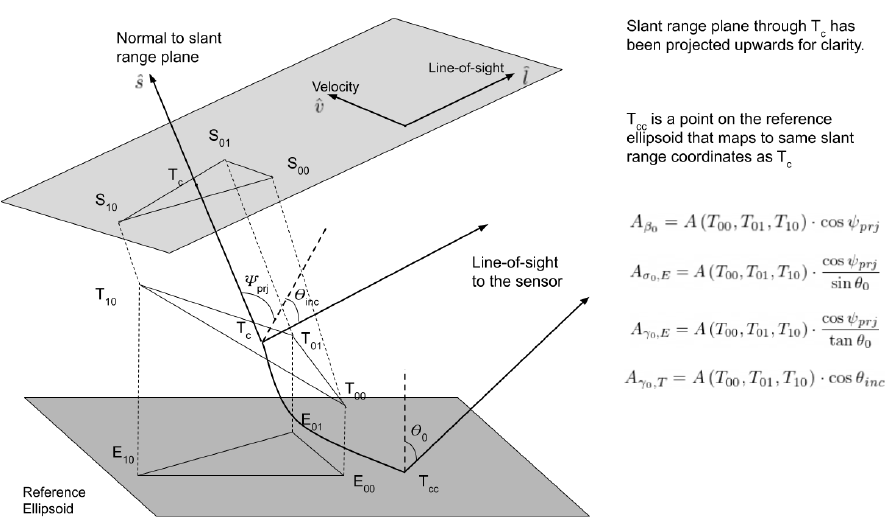
Figure 1. Normalization area relations for different SAR calibration levels of a single triangular DEM facet. The altitude of the DEM points T 00 , T 01 and T 10 have been exaggerated for clarity. The normal vectors to the reference ellipsoid and the DEM facet are shown as dashed lines. The slant-range plane passes through T c , but we have projected the plane upwards for clarity. T cc is a point on the reference ellipsoid that maps to the same slant-range coordinates as T c , and the constant slant-range curve connecting these two points is shown. This image is comparable to Figures 2 and 5 of [4]. The unit vectors ˆ l , ˆ v and ˆ c are used for defining interferometric baselines and are described in greater detail in Appendix